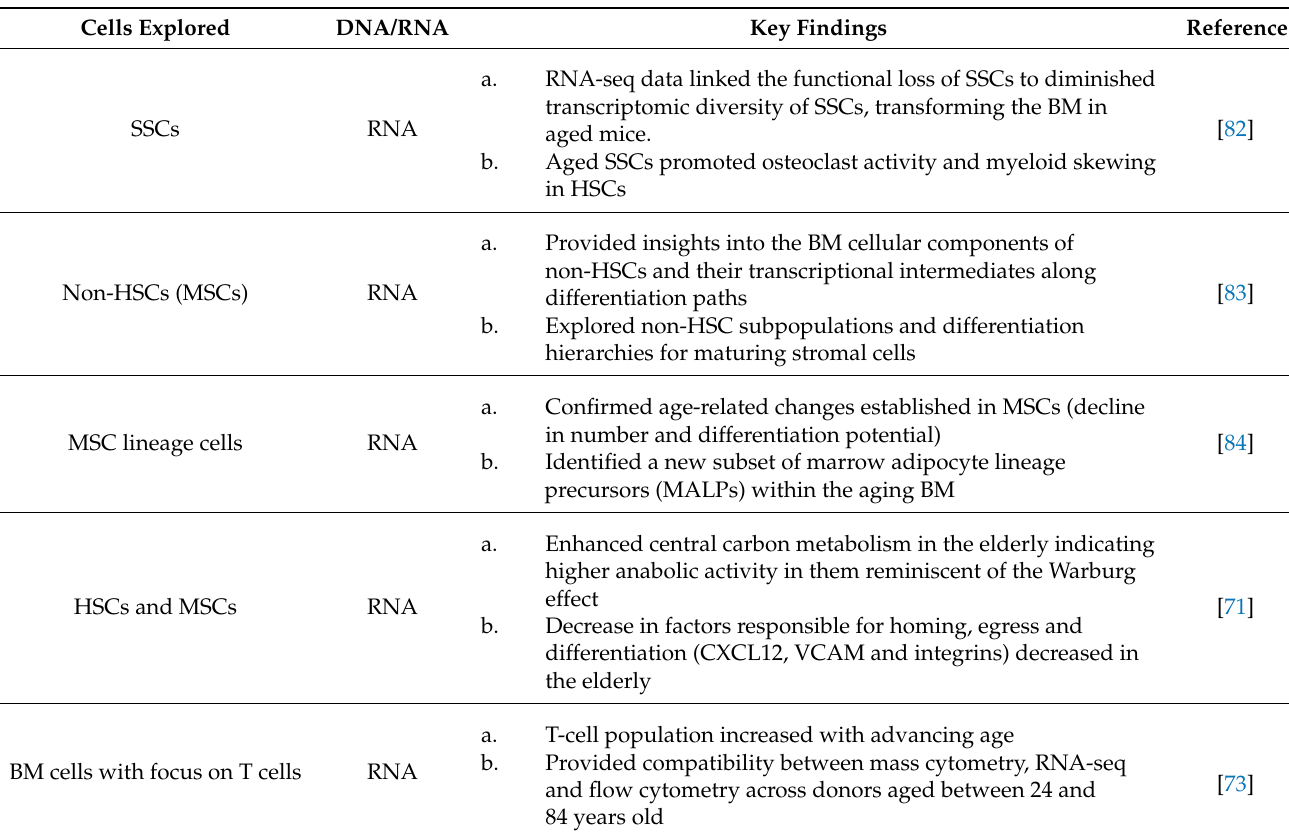
Table 1. List of key studies performed using NGS in aging BM